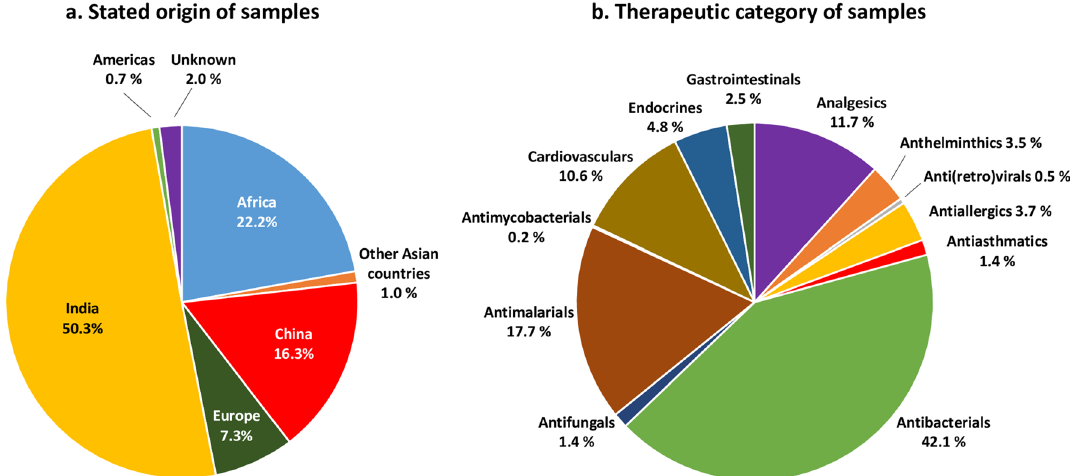
Figure 2. Stated origin ( a ) and therapeutic categories ( b ) of the 1919 included